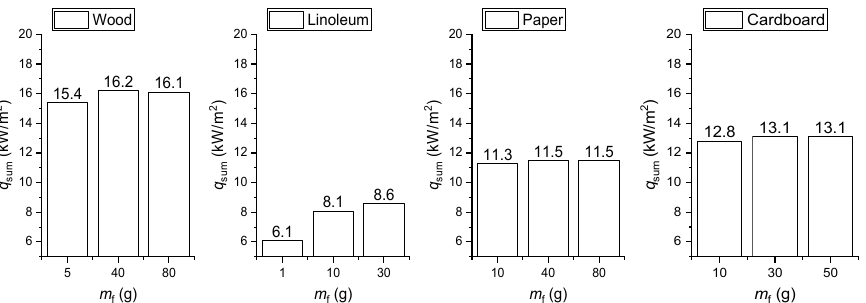
Figure 6. Total heat flux ( q sum ) during flame combustion when factoring in the actual maximum temperatures of the gas of the SC (for different initial masses of burning materials).